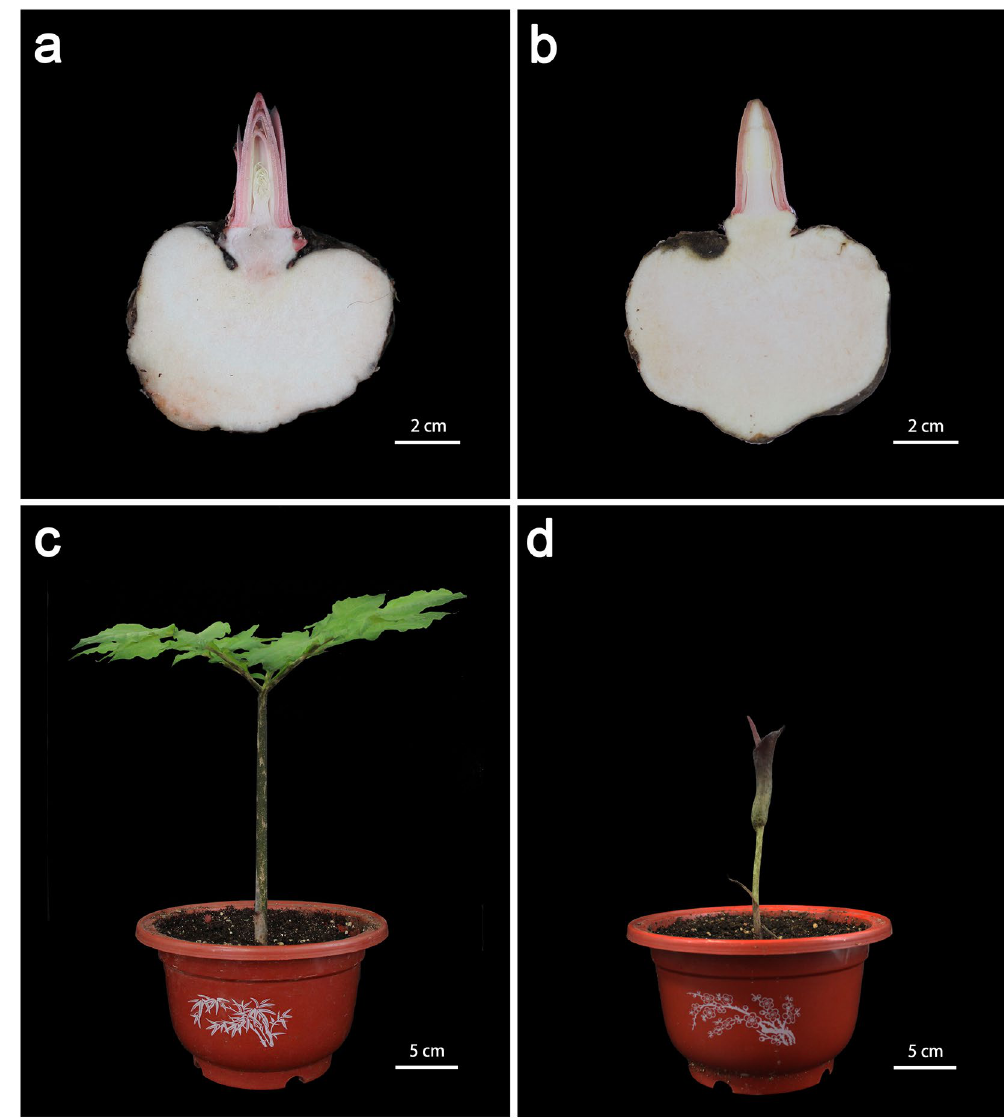
Figure 1. Leaf and flower of A. konjac. ( a ) Leaf bud. ( b ) Flower bud. ( c ) Leaf. ( d ) Flower.